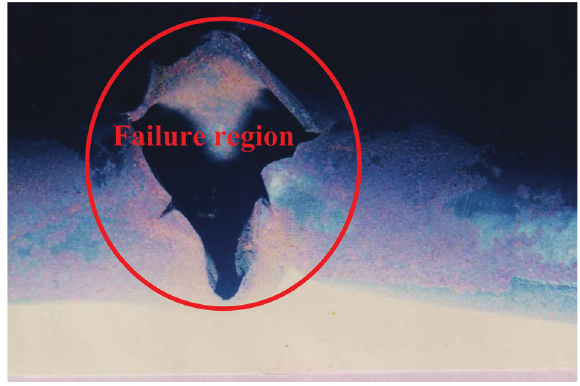
Figure 2: As received failed region of primary superheater tube.